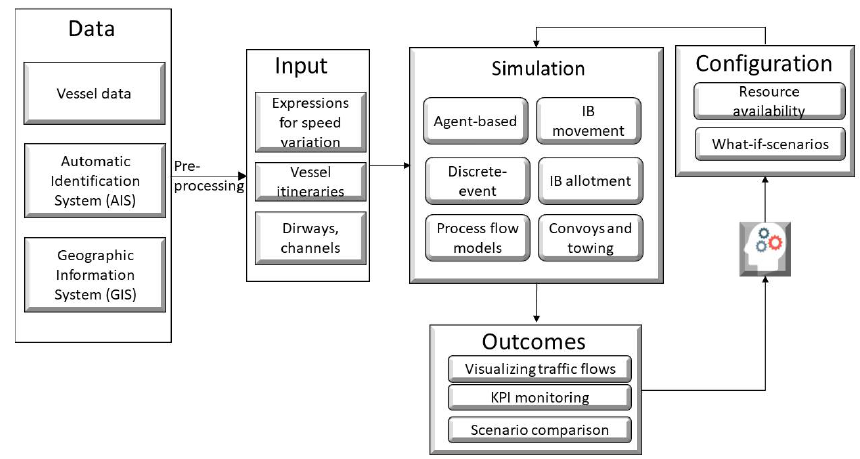
Figure 3. Tool schematic.